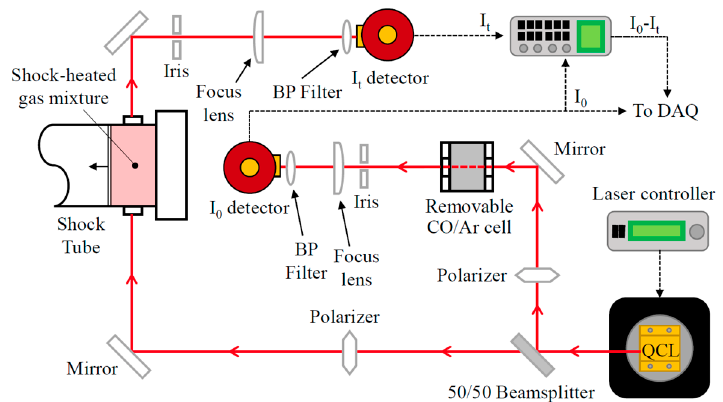
Figure 3. Schematic of the laser diagnostic used during this study to measure the CO concentration behind reflected shock waves.